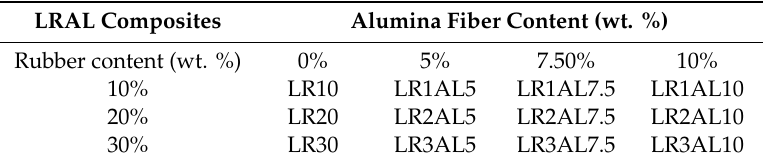
Table 1. Composition of AF reinforced recycled EPDM rubber blended epoxy-based composites. LRAL